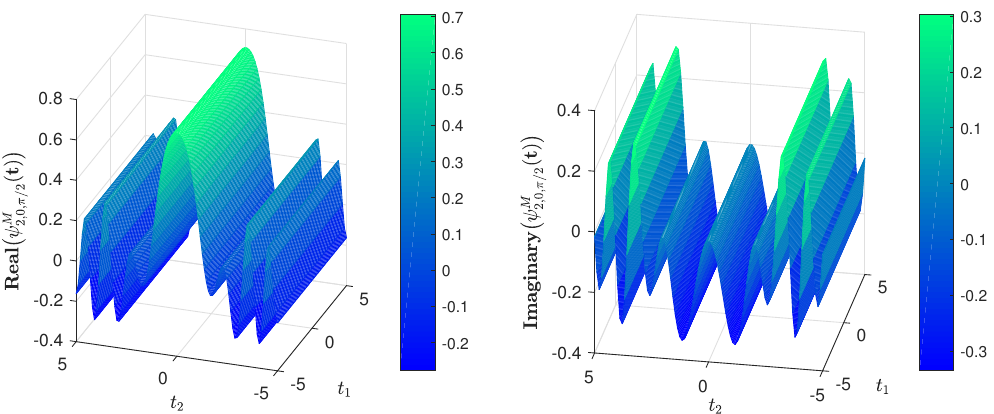
Figure 3. The linear canonical ridgelet waveforms for M = ( 1/4,1/6; − 3,2 ) at scale a = 2, location b = 0, and orientation θ = π /2.